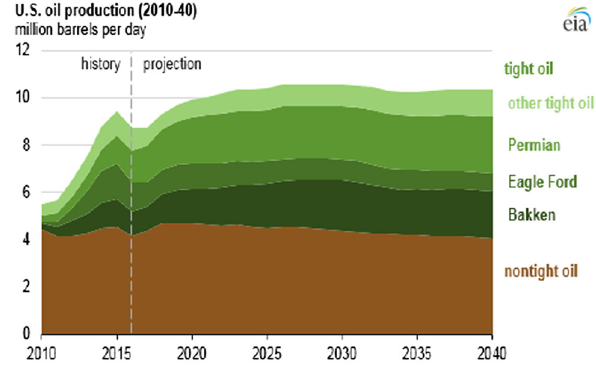
Fig. 1. Oil production from tight formations including shale plays has just shared for more than 50% of total oil production in US (Alfarge et al. 2017). Hoffman and Evans (2016) reported that 4 million barrels per day as an incre- ment in US oil daily production comes from these uncon- ventional oil reservoirs. From 2011 to